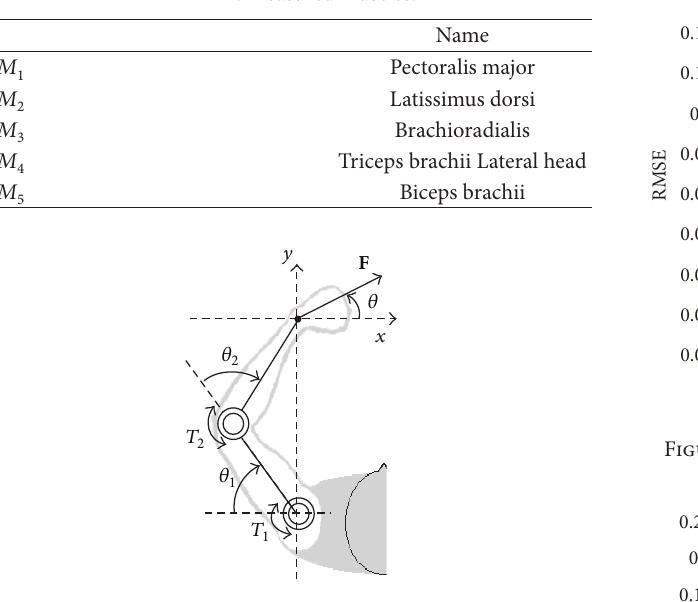
Figure 5: Upper limb model.